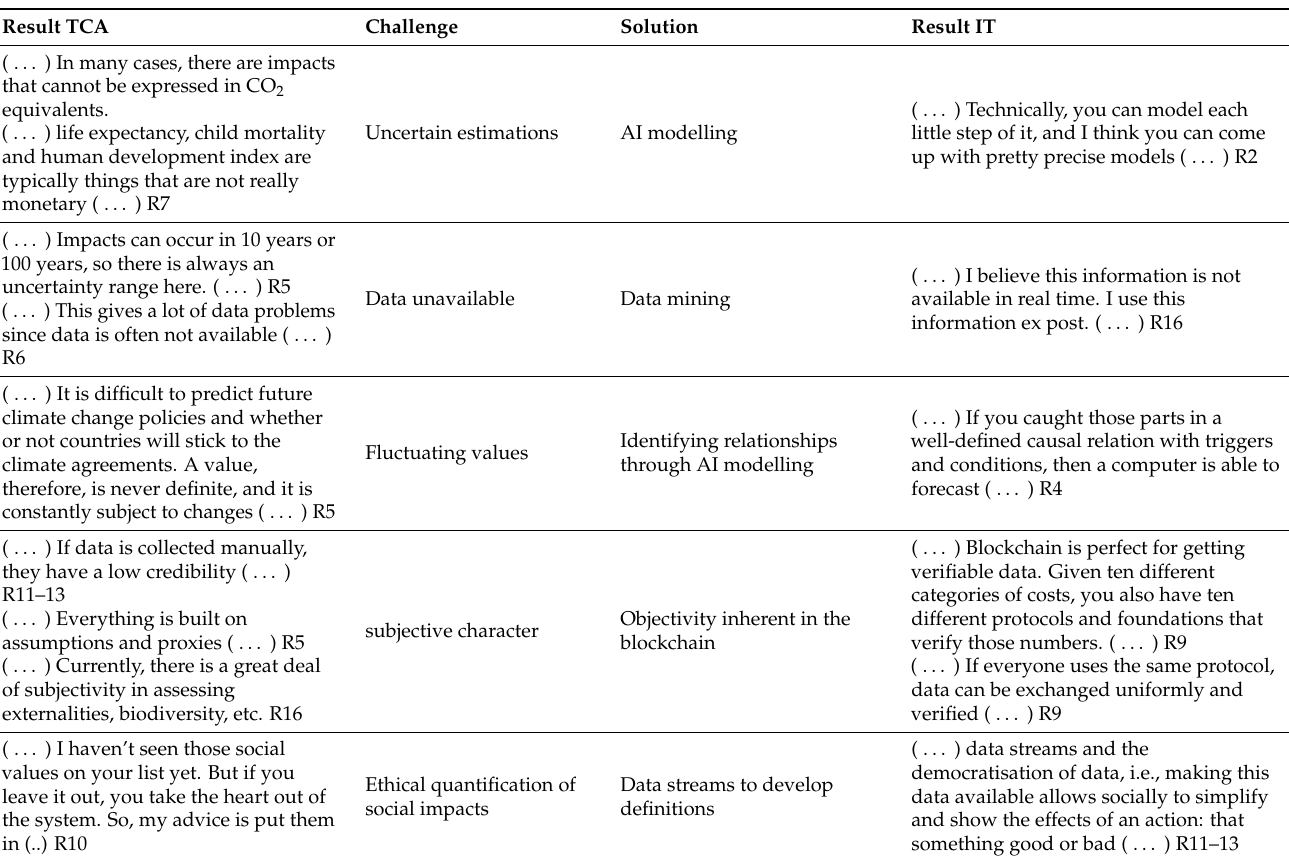
Table 4. TCA accuracy and